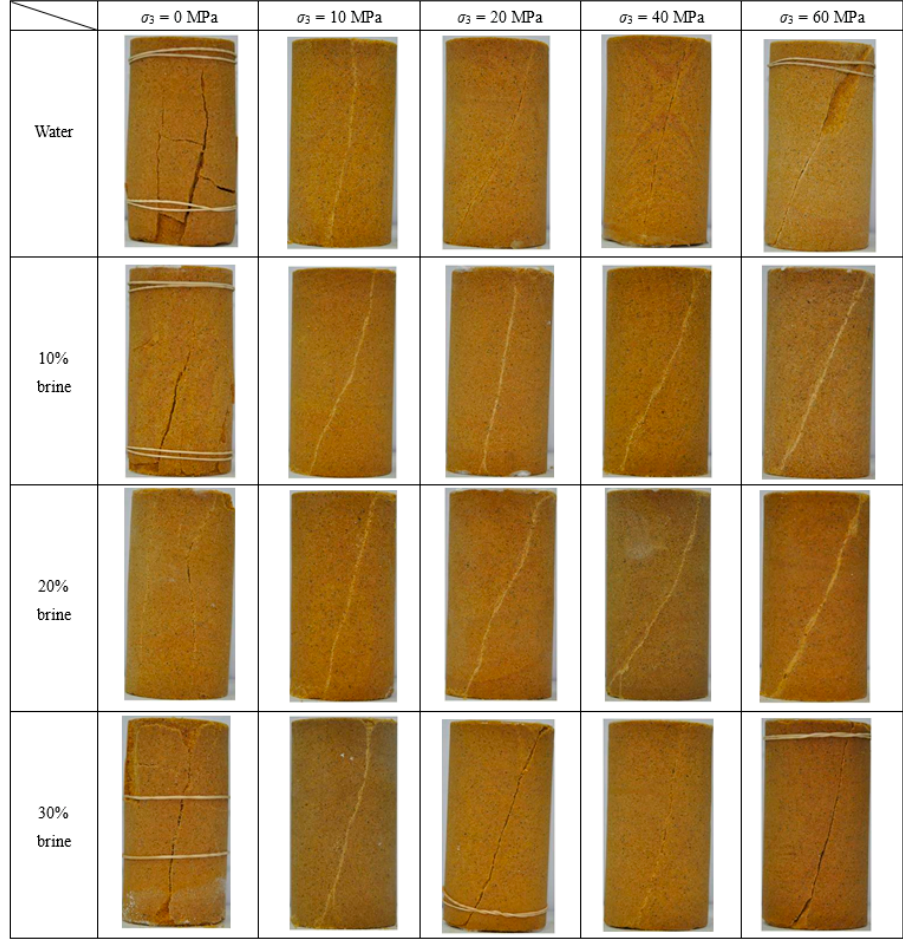
Figure 16. Ultimate failure modes of saturated sandstone specimens under triaxial compression.